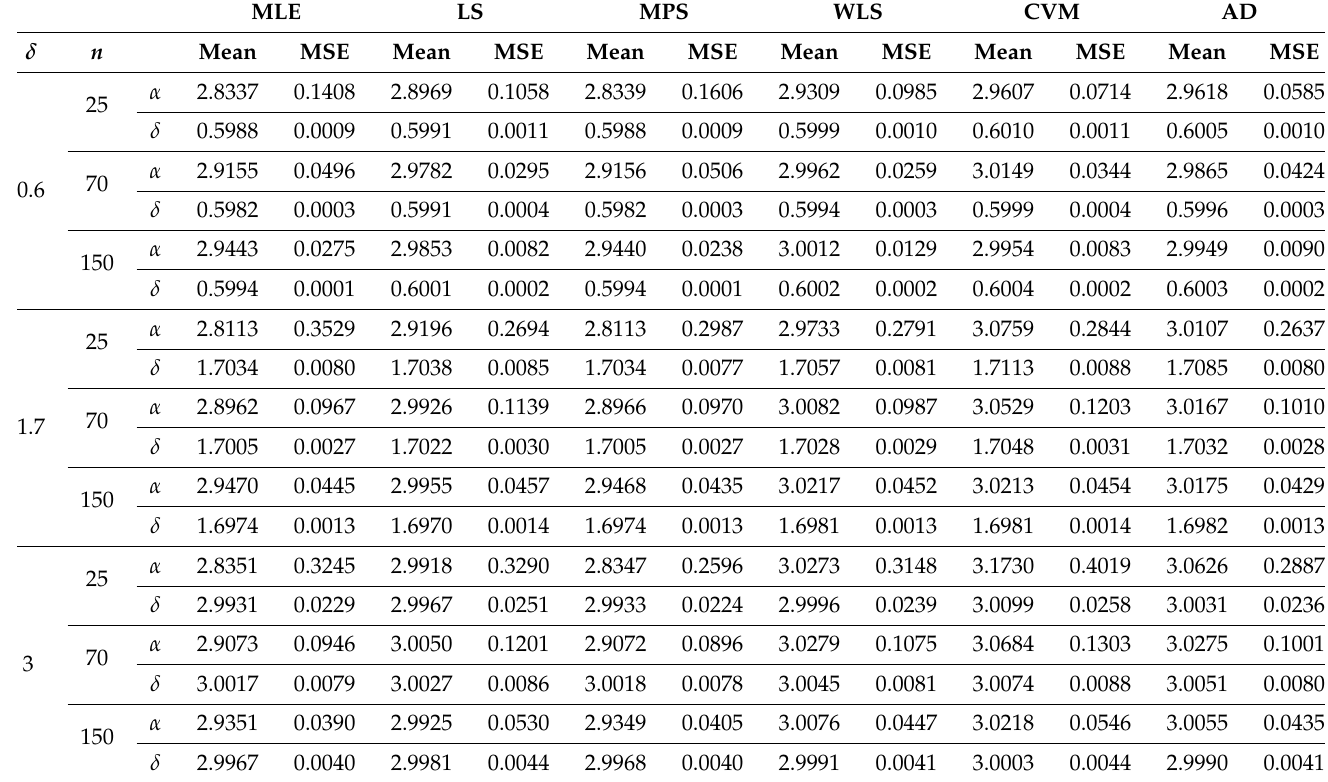
Table 3. Mean and MSE of the MLE, LS, MPS, WLS, CVM and AD estimate for MKITL distribution when α =